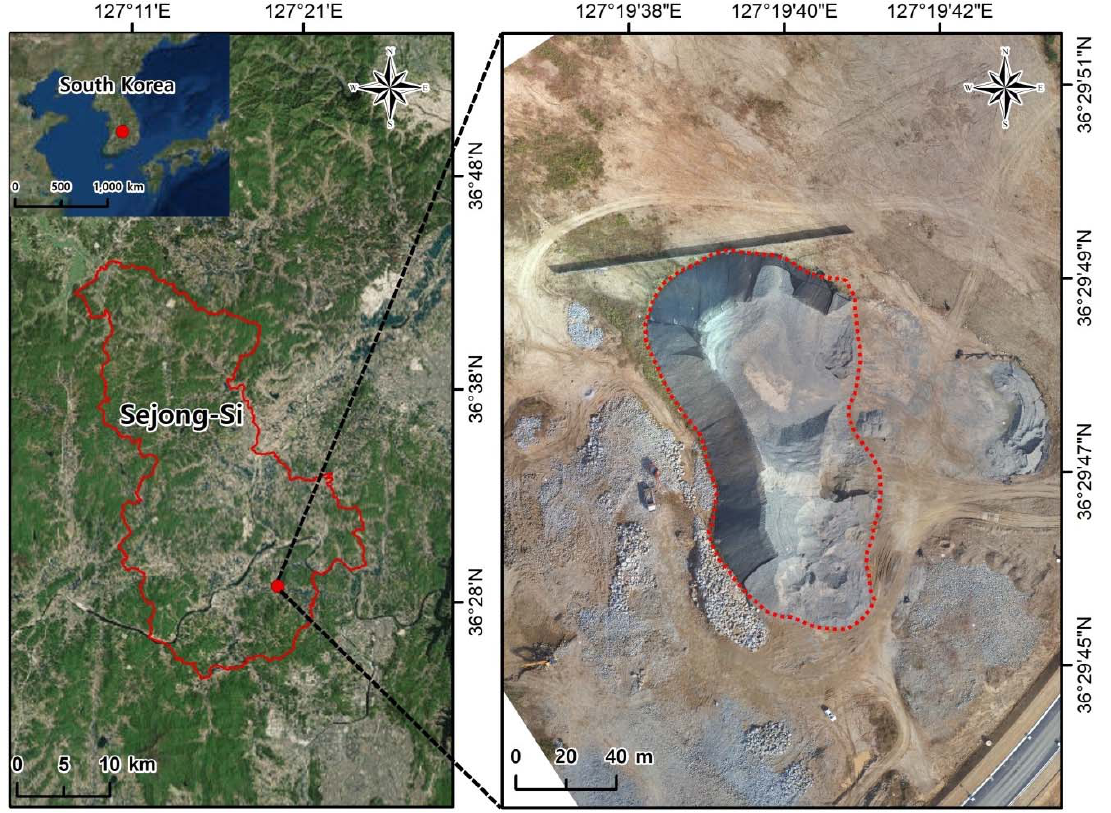
Figure 1. Location of the study area, Jipyeon-ri in Sejong City, South Korea.